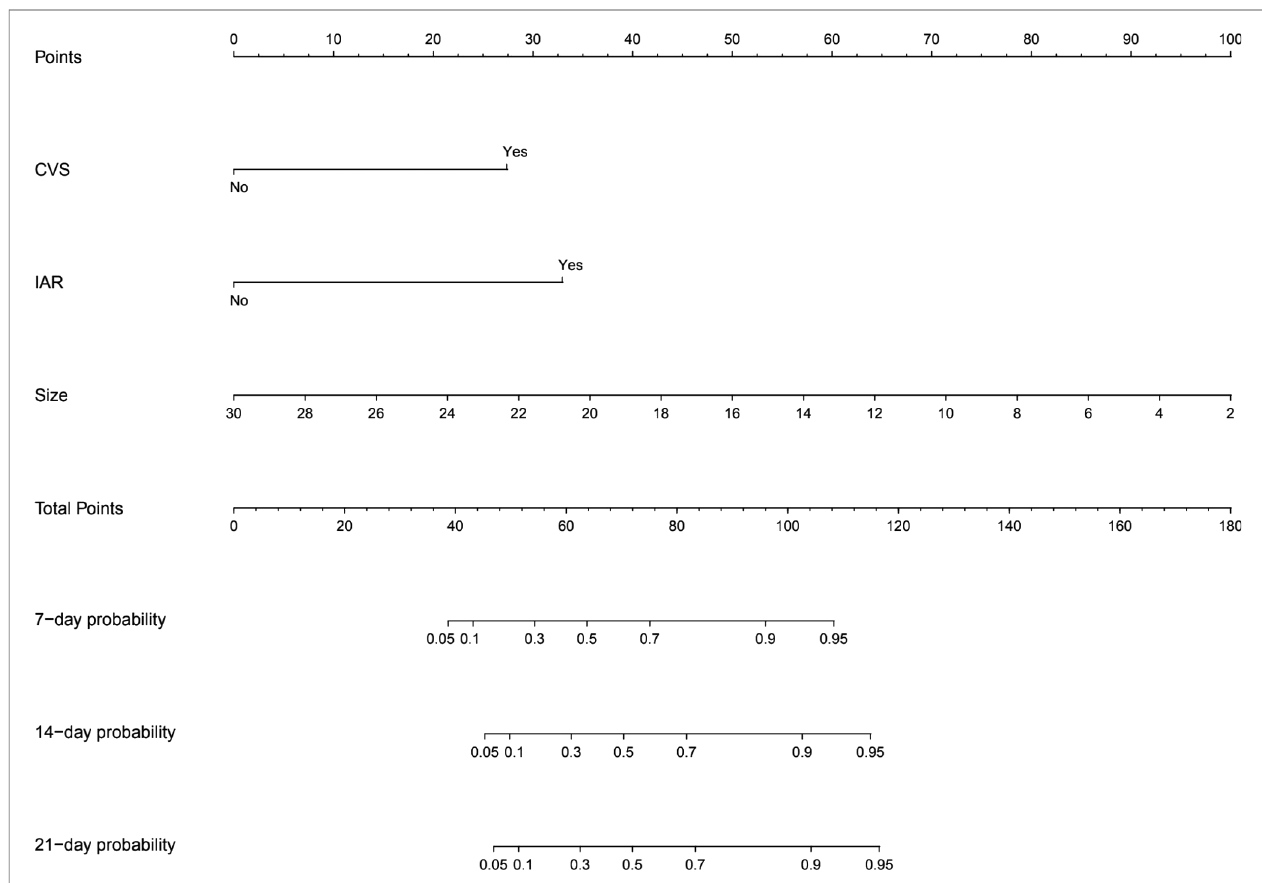
FIGURE 1 | Nomogram for predicting 7-,14-,and 21-day probability of DCI for individual